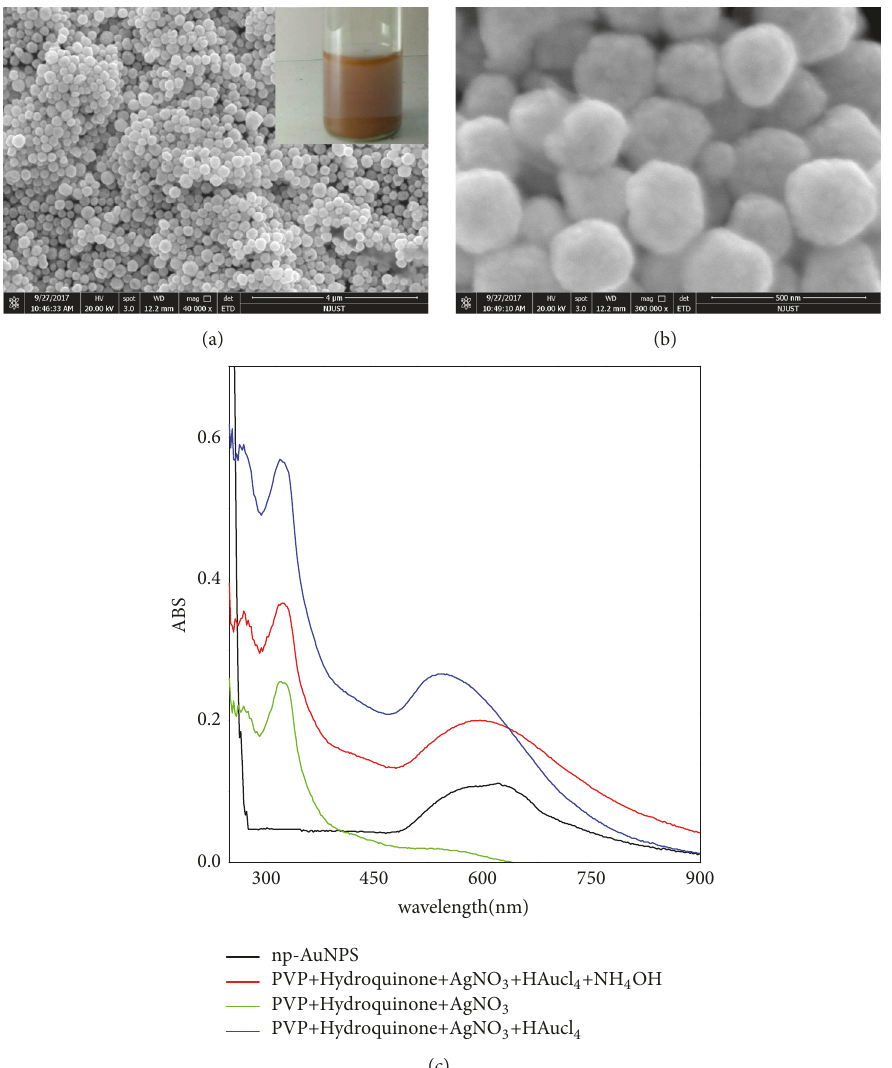
Figure 2: SEM images (a and b) of nanoporous gold nanoparticles (np-AuNPs) and typical UV-Vis absorption spectra (c) of the reactions during the prepared process of